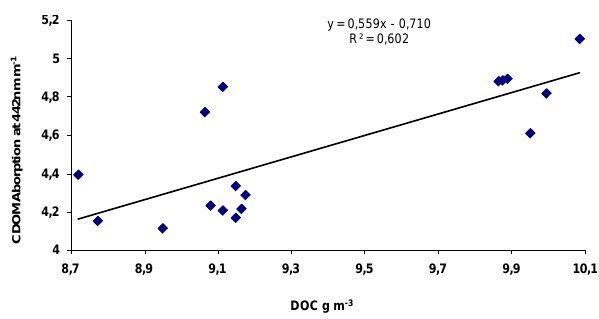
Fig. 11. Relationship between DOC and the absorption coefficient of the filtrate at 442nm against pure water as